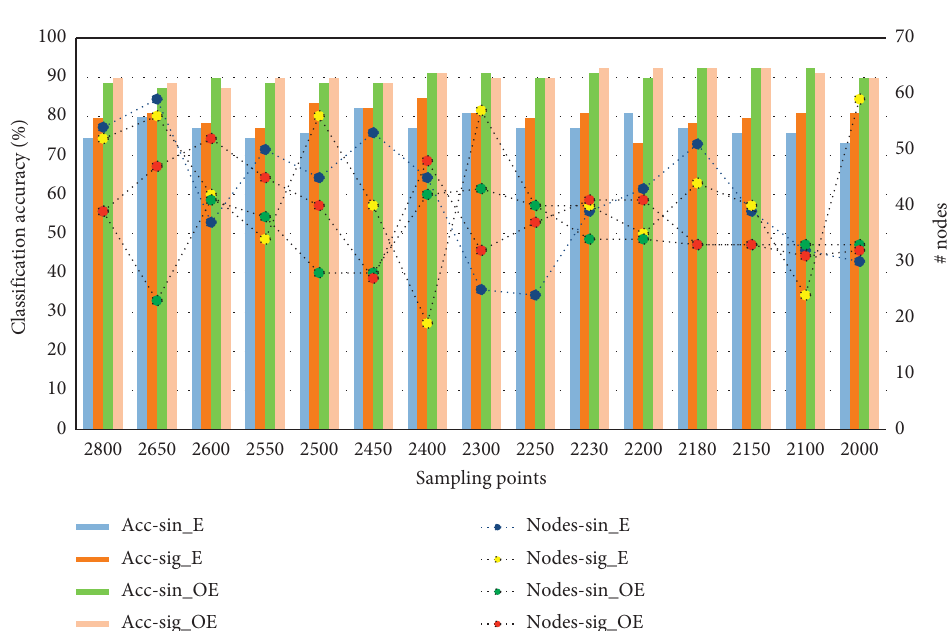
Figure 6: Bar plot visualizes the performance corresponding to each sampling point number.